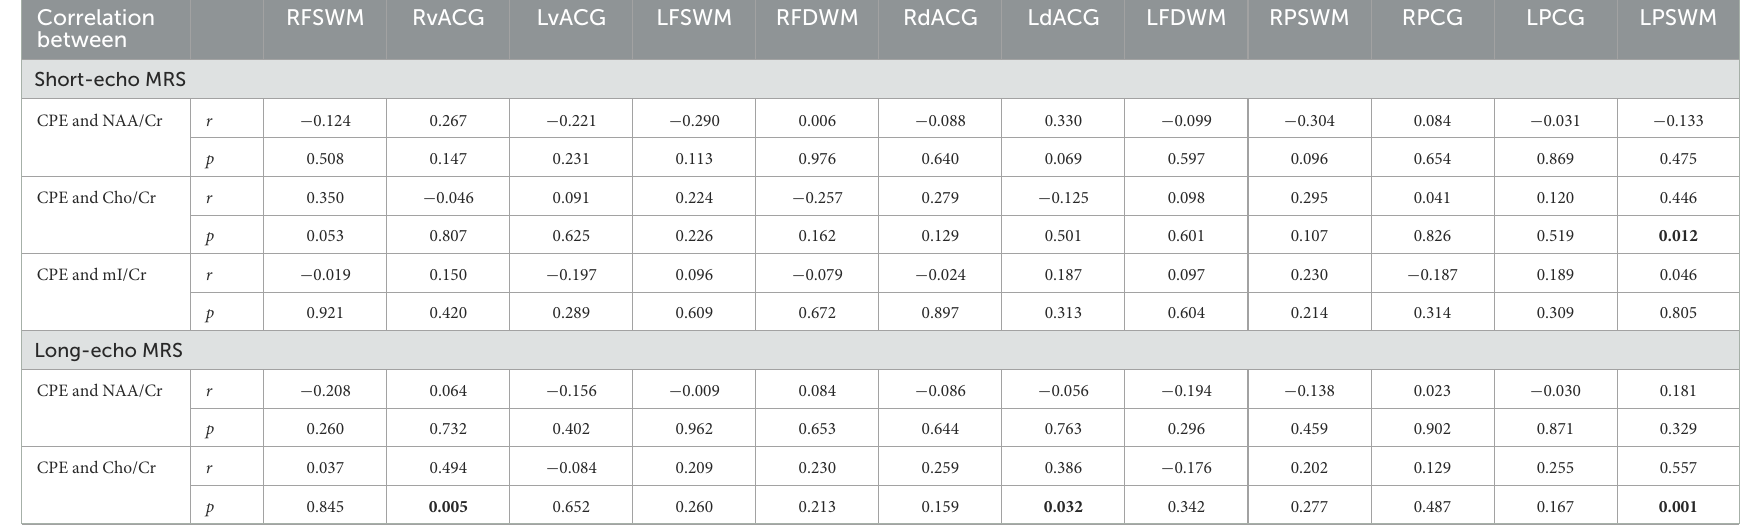
TABLE 3 Correlations of CPE score and neurometabolite ratios in the observed brain regions. Correlation between